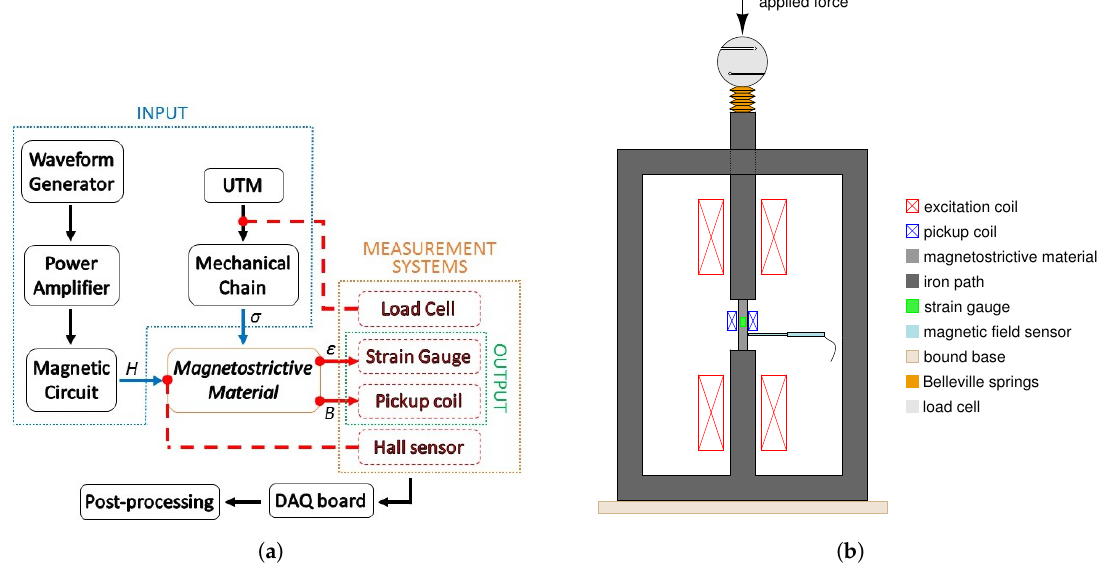
Figure 1. Illustration of the setup used for the characterization of magnetostrictive material. ( a ) Blocks diagram. ( b ) 2-D